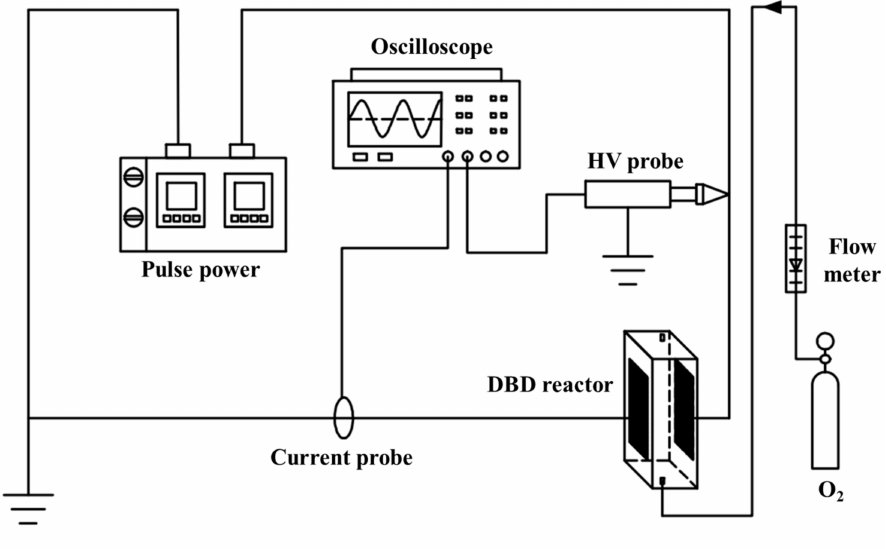
Figure 11. Bench-scale apparatus of DBD plasma for Indigo Carmine decomposition.